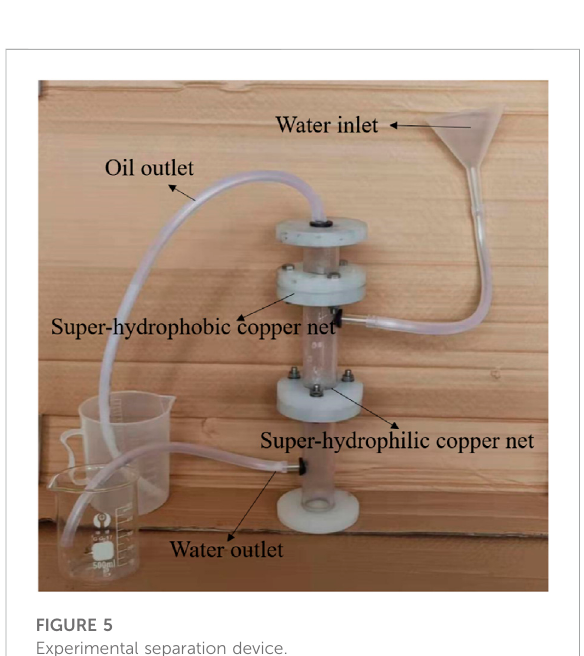
FIGURE 5 Experimental separation